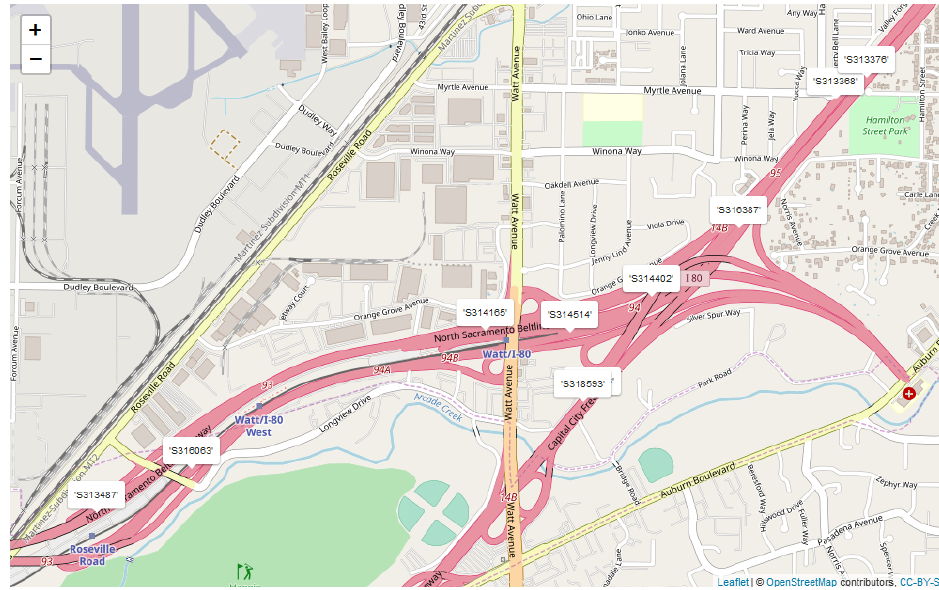
Figure 1. A map of sensor locations from Phase